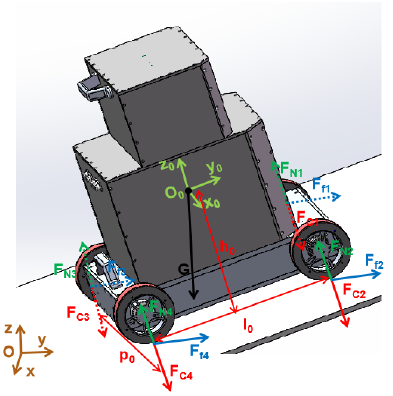
Figure 7. Mechanical model.